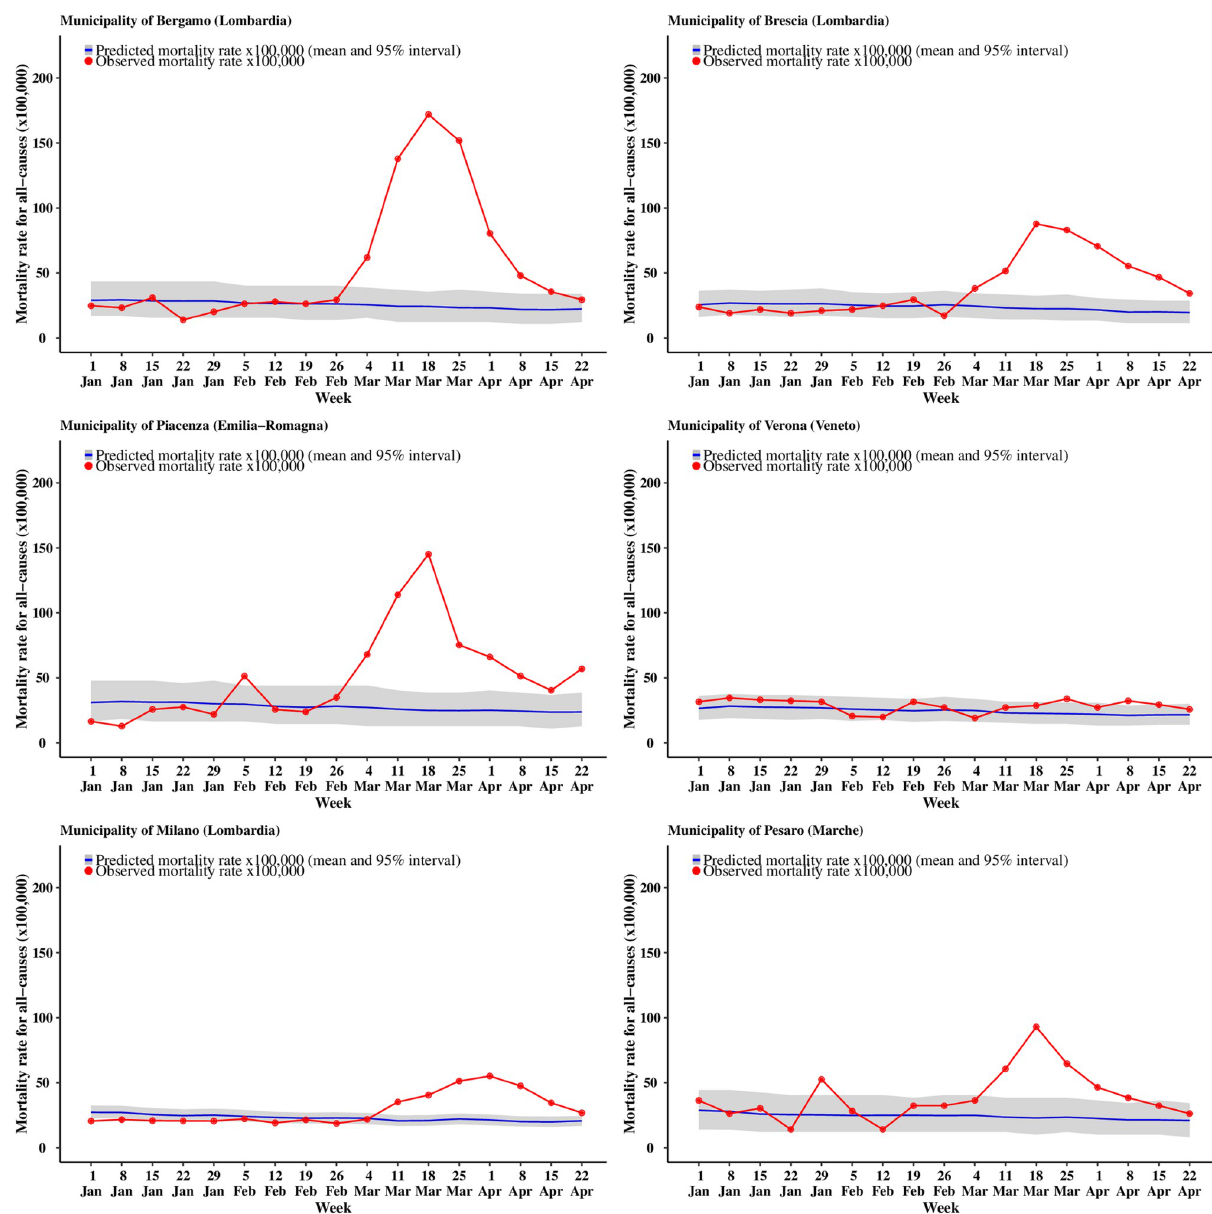
Fig 6. Trend for all cause mortality (females) in selected municipalities. The blue curve shows the posterior predictive mean predicted from the 2016–2019 model, while the gray ribbon describes the posterior 95% interval; the observed number of deaths for 2020 are in